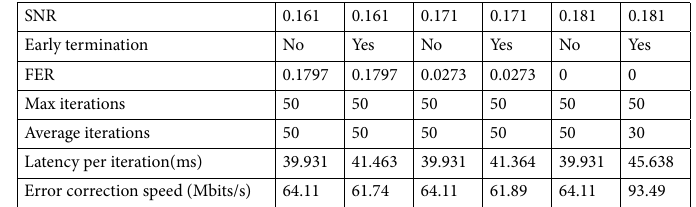
Table 3. Performance comparison of the layered BP decoder when decoding 128 codewords with/without early termination.